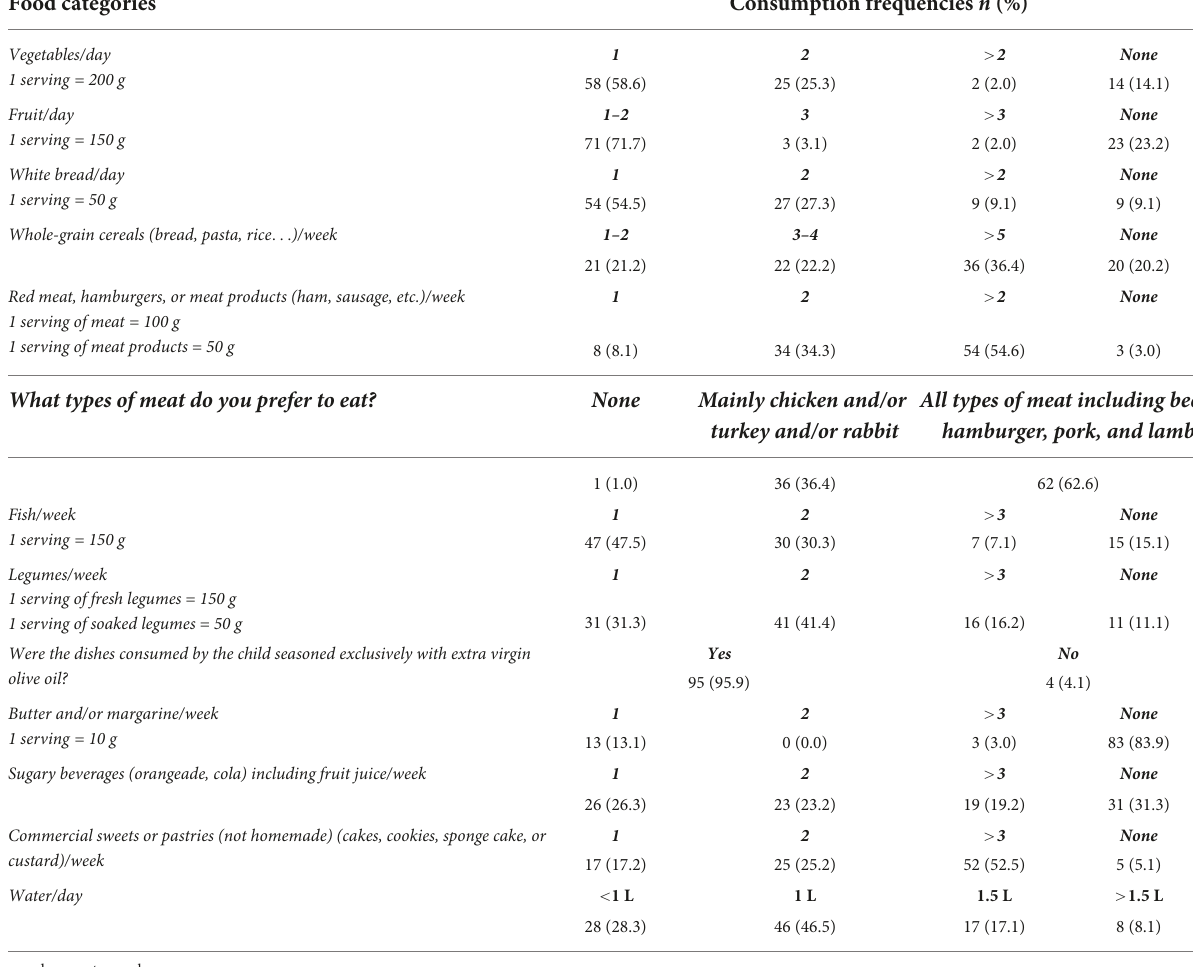
TABLE 2 Eating habits in the pre-pandemic